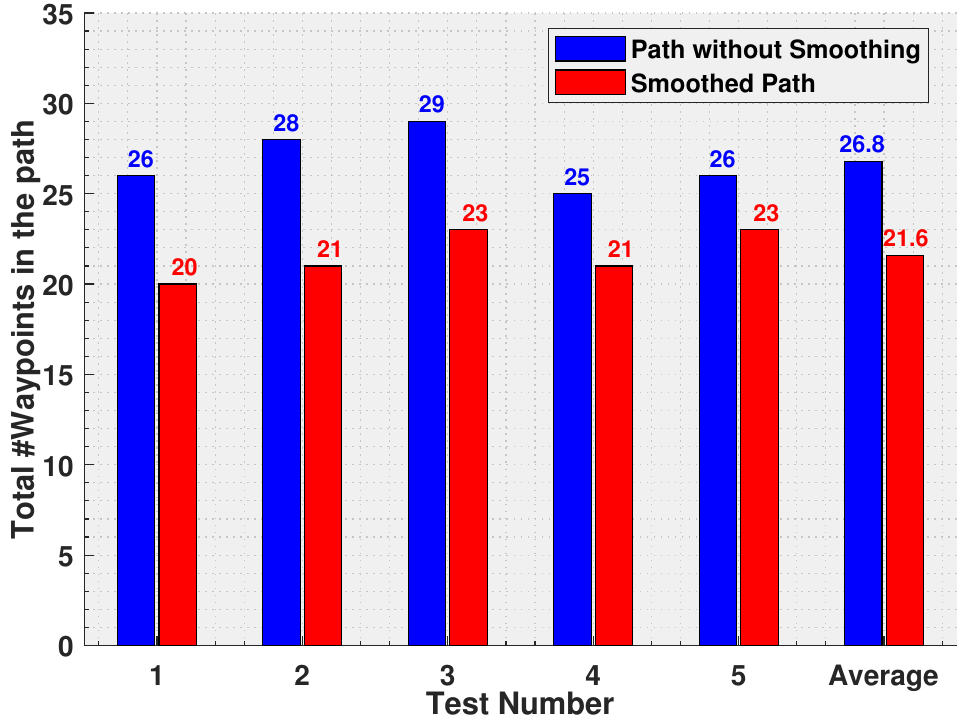
Figure 6. Comparison of total waypoints for original paths and 2D smoothed paths for a swarm of 5